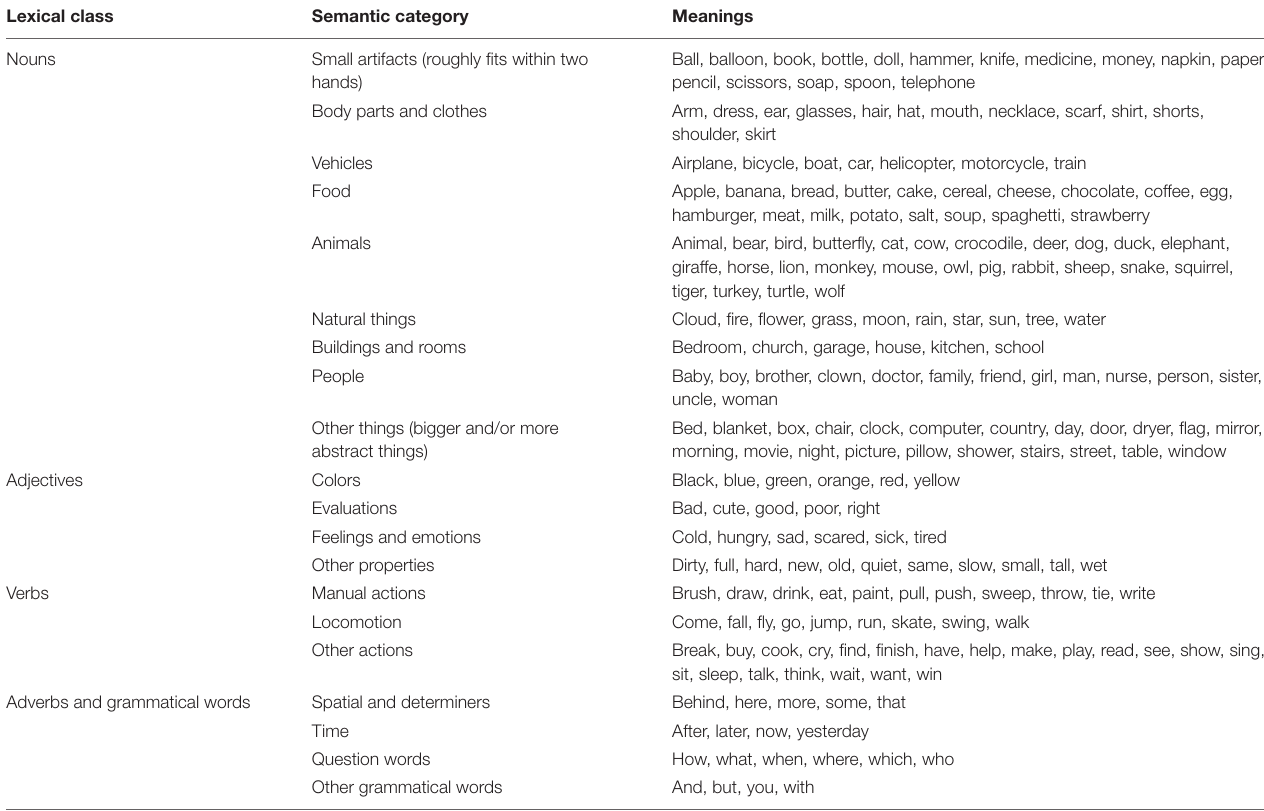
TABLE 2 | Lexical class and particular semantic categories of the 220 meanings for which we had iconicity ratings in all four languages. Lexical